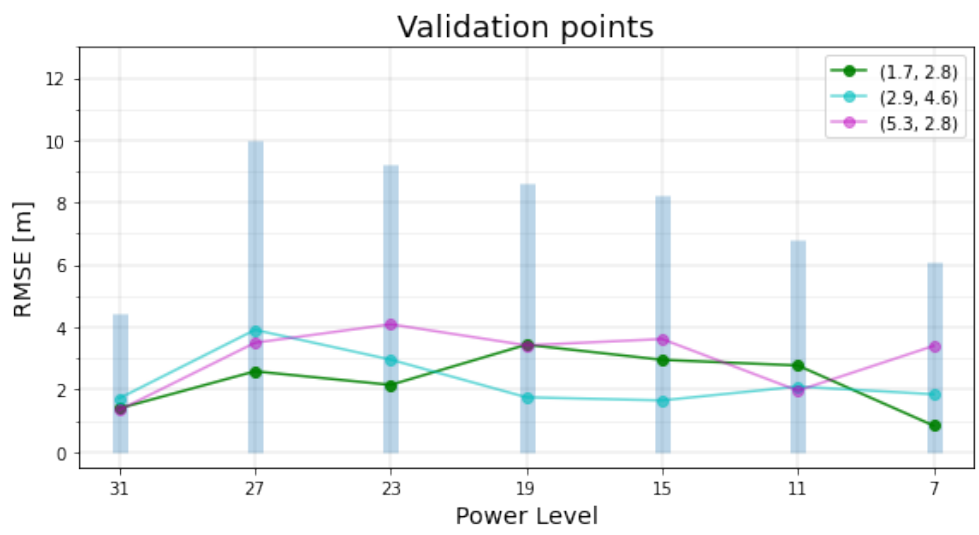
Figure 12. Test points MSEs.